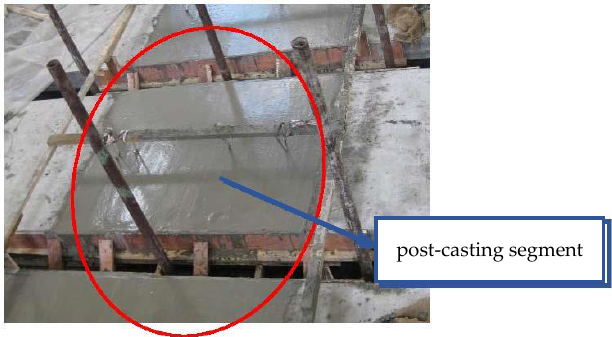
Figure 3. Casting of the middle segment of girders B2 to B4.